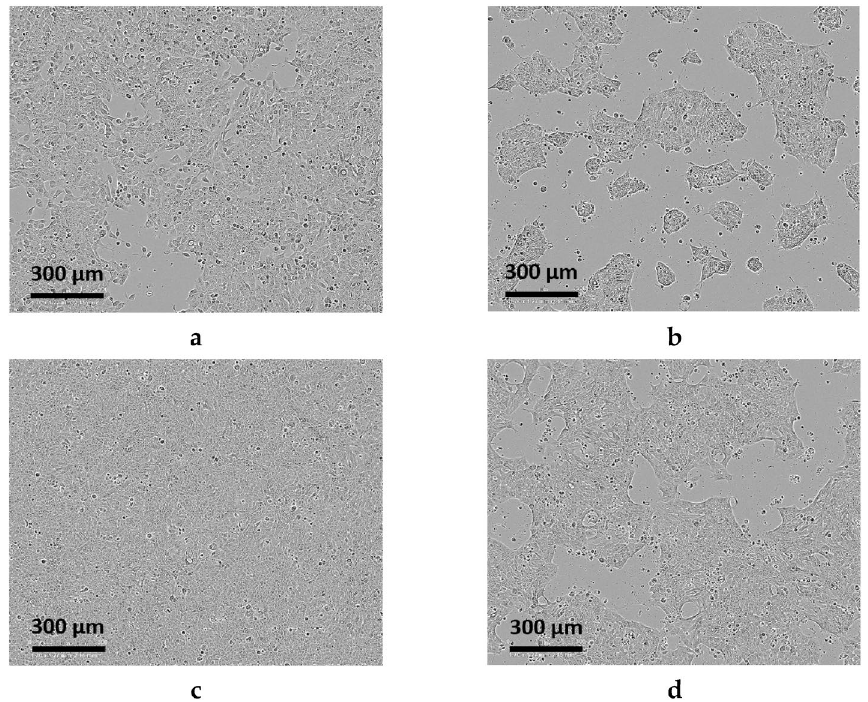
Figure 2. Detroit 562 monolayer development was monitored at both 28 ( a , b ) and 48 h ( c , d ). Coating with collagen I ( a , c ) facilitated Detroit 562 monolayer formation comparatively greater than uncoated wells ( b , d ). Images were taken at ×10 objective at the Incucyte and representative of 3 biological replicates with 1 technical replicate each. Each well was initially seeded with 2 × 10 5 Detroit 562 cells/mL.